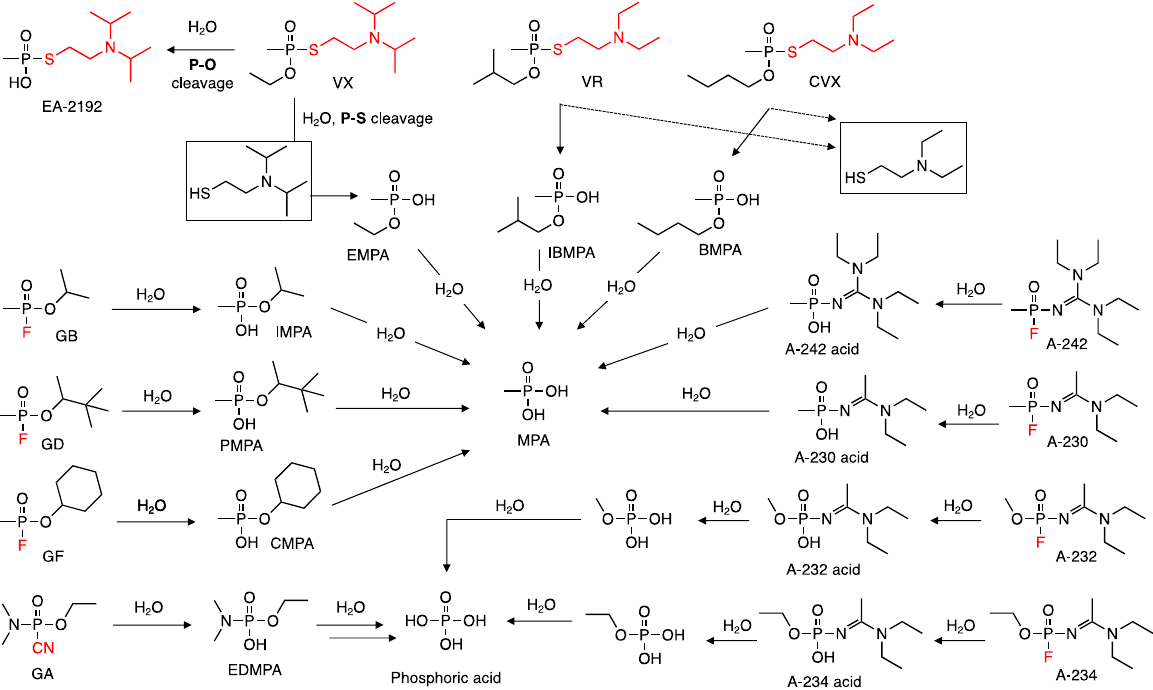
Figure 2. Hydrolytic degradation pathways for OPNAs and intermediary species in the processes. The more reactive leaving group in each agent is denoted in red.